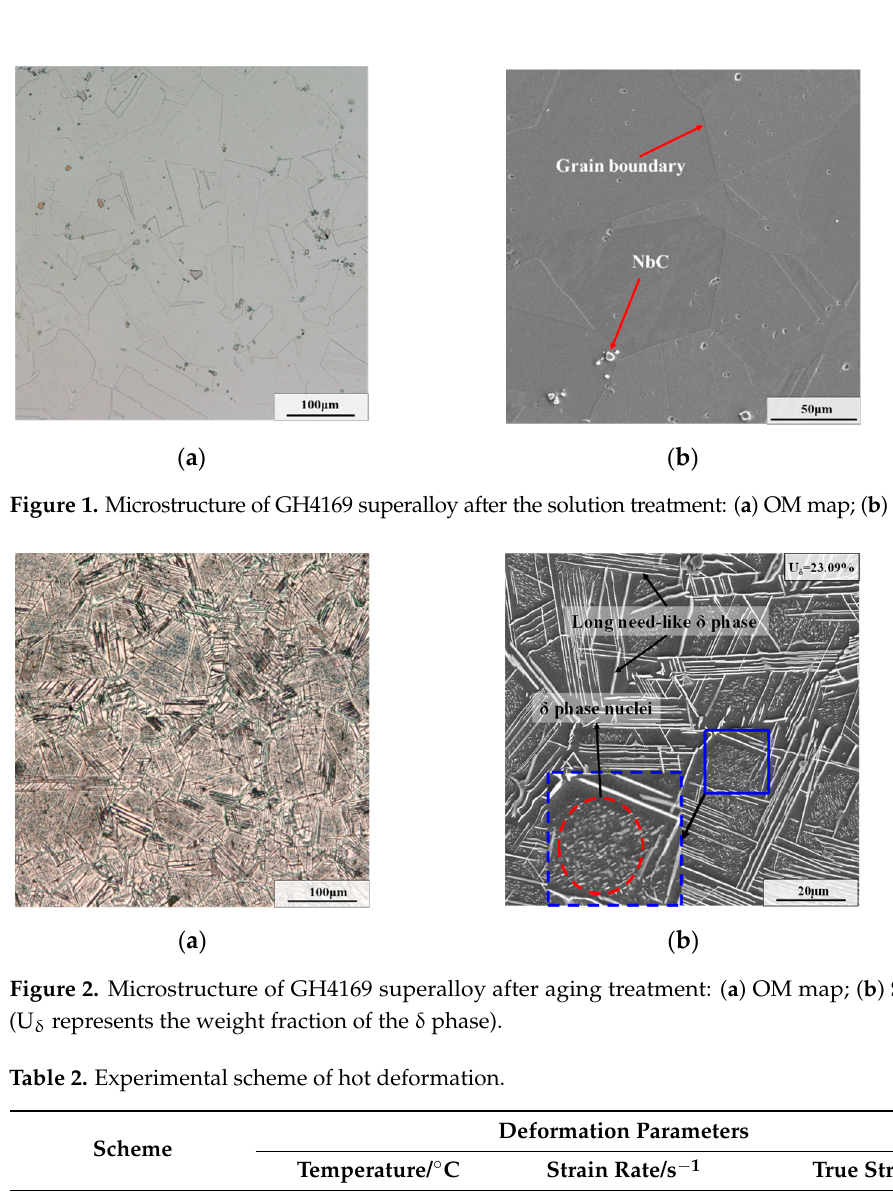
Table 1. Chemical composition of studied GH4169 superalloy.